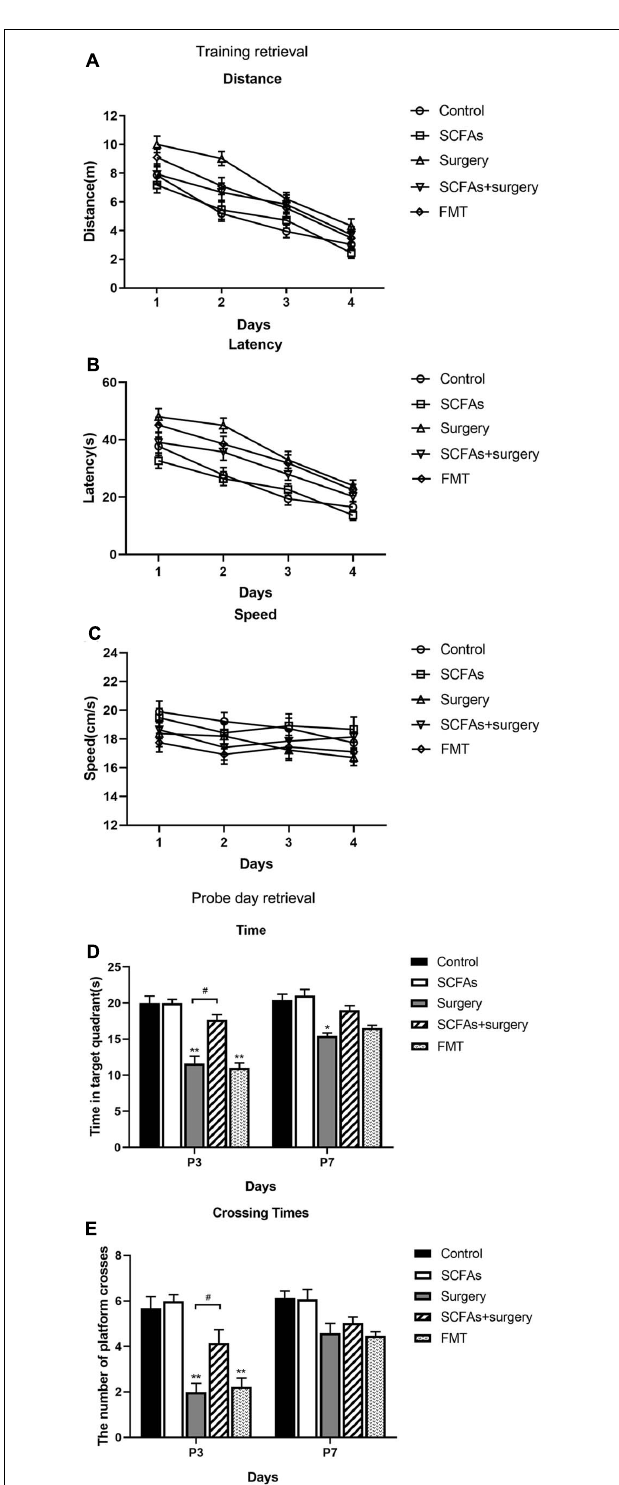
FIGURE 2 | All mice showed improvements in swimming latency and distance over 4 consecutive training days in a Morris water maze (MWM). The mice in the SCFAs + surgery group performed better (swam less distance and less latency) than those in the surgery group on training days 2 and 3.